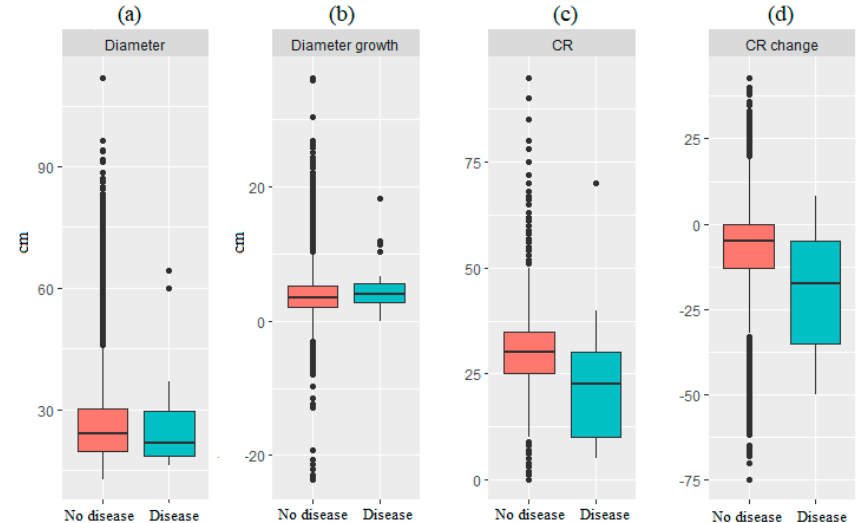
Figure 4. Boxplots showing the distribution of pine foliar disease as a function of different tree-level predictor variables; ( a ) diameter, ( b ) diameter growth, ( c ) crown ratio, and ( d ) crown ratio change. Trees affected by disease are shown in blue and trees with no record of foliar disease are shown in red.